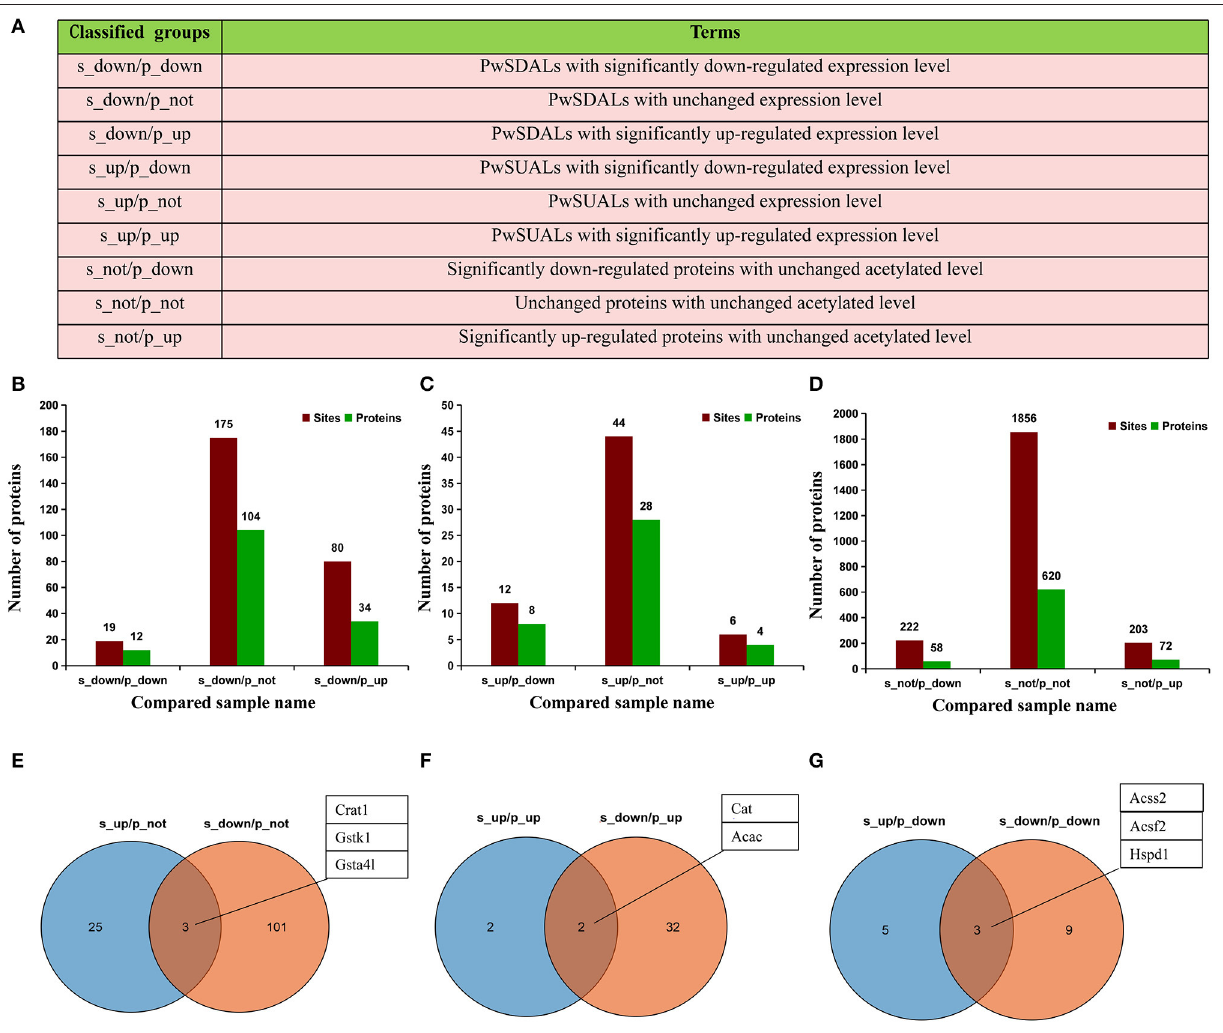
FIGURE 8 | Integrated analysis of proteome and acetyl-proteome data. (A) The proteins were divided into nine groups according to both their expression levels and acetylation levels. (B–D) The numbers of Kac sites and corresponding proteins in each group. Dark green represents the number of proteins, and dark red represents the number of Kac sites in the same group. (B) Three groups including PwSDALs with unchanged expression level (104/150), PwSDALs with downregulated expression level (12/150), and PwSDALs with upregulated expression level (34/150). (C) Three groups including PwSUALs with downregulated expression level (8/40), PwSUALs with unchanged expression level (28/40), PwSUALs with upregulated expression level (4/40). (D) The 782 proteins for which the differences of their acetylation levels between pre- and peak-laying hens did not reach the threshold value, including upregulated proteins (58/782), unchanged proteins (620/782), and downregulated proteins (72/782). (E–G) The Venn diagrams show the proteins which showed both significantly up- and downregulated acetylation levels. (E) Three PwSU_DALs with unchanged protein levels. (F) Two PwSU_DALs with upregulated protein levels. (G) Two PwSU_DALs with downregulated protein